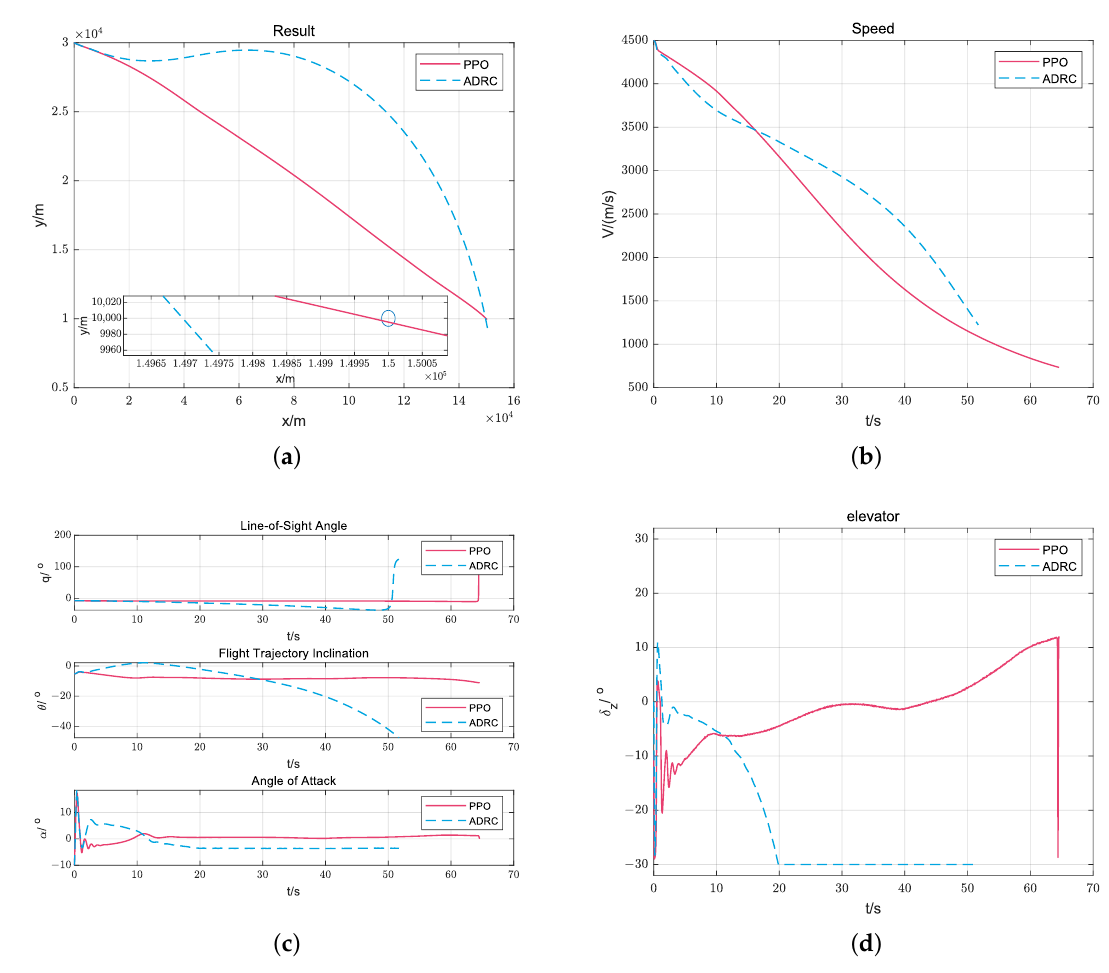
Figure 10. Simulation with fault and uncertainty. ( a ) Flight Trajectory. ( b ) Speed curve. ( c ) Angle Curve. ( d ) Elevator